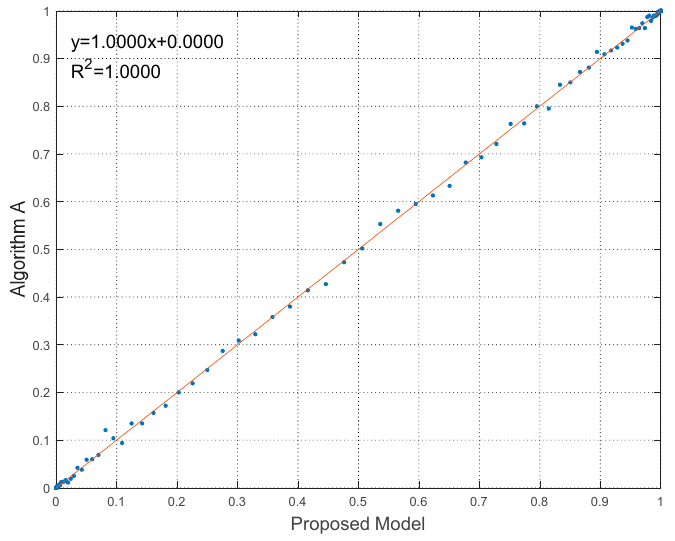
Figure 14. Linear regression of robustness results in Experiment 1.